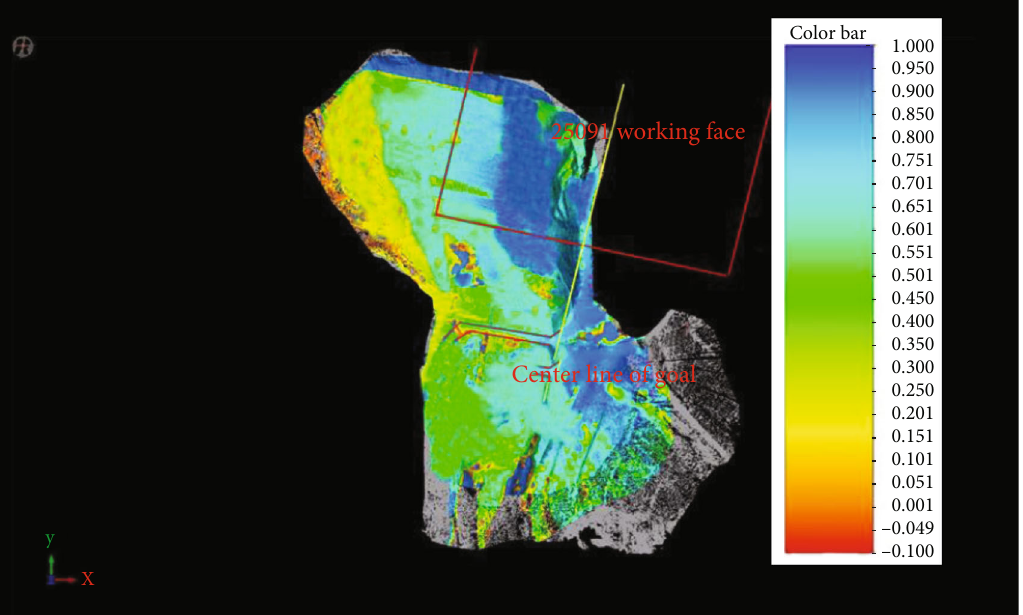
Figure 10: Comparison of point cloud DEM in the third and fi rst phases.